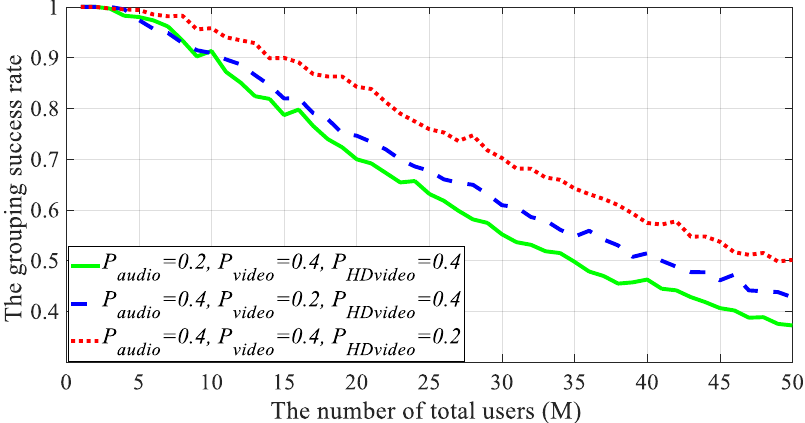
Figure 7. The grouping successful rate of the single relay-allowed modified pilot-based grouping method in scenario 1.